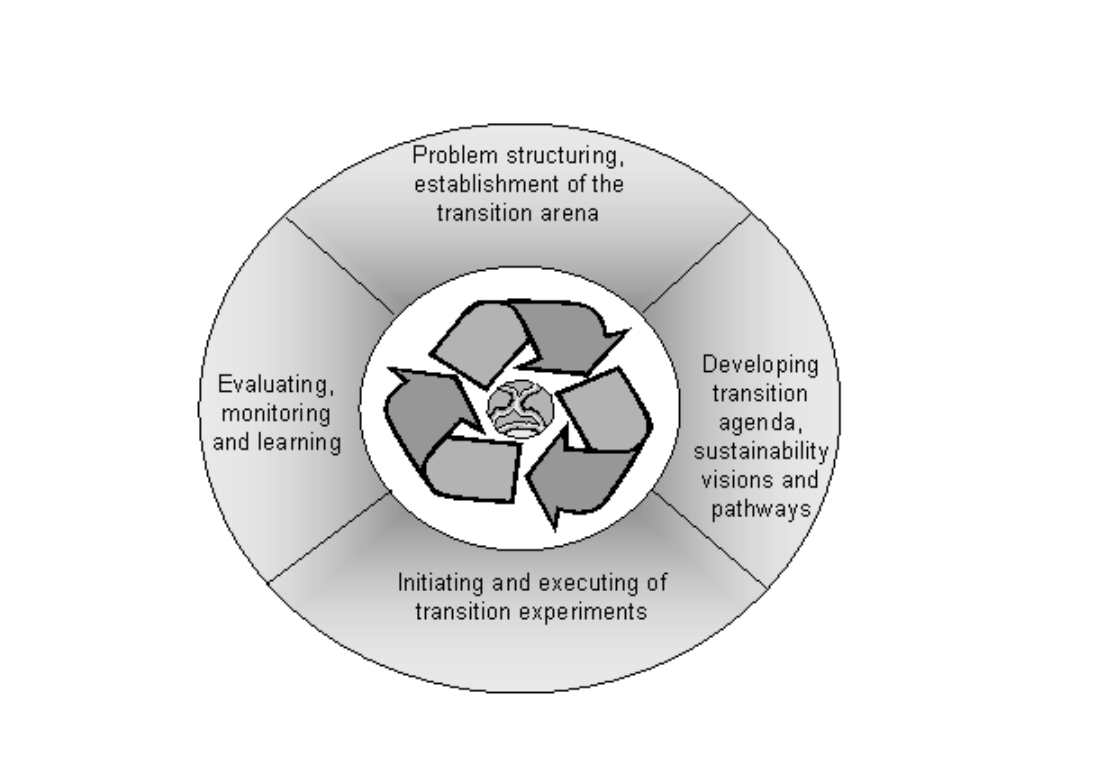
Fig. 1. Activity clusters in transition